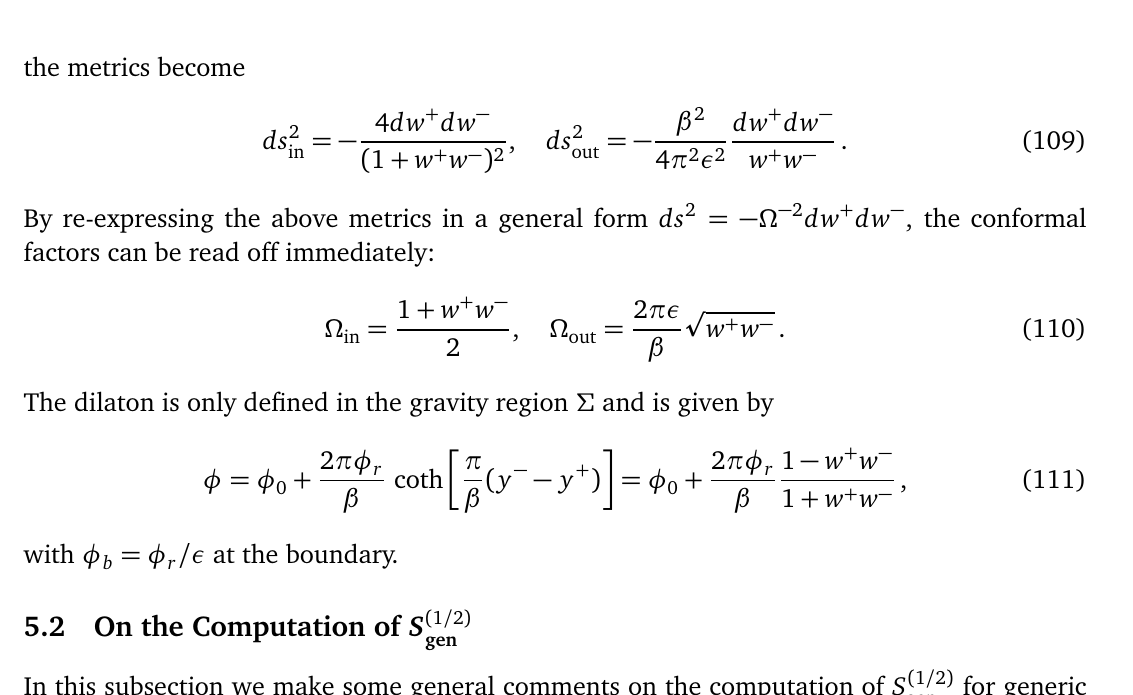
Figure 20: Penrose diagram for the eternal black hole coupled to two rigid Minkowski regions referred to as baths. Figure modified from [ 69 ]